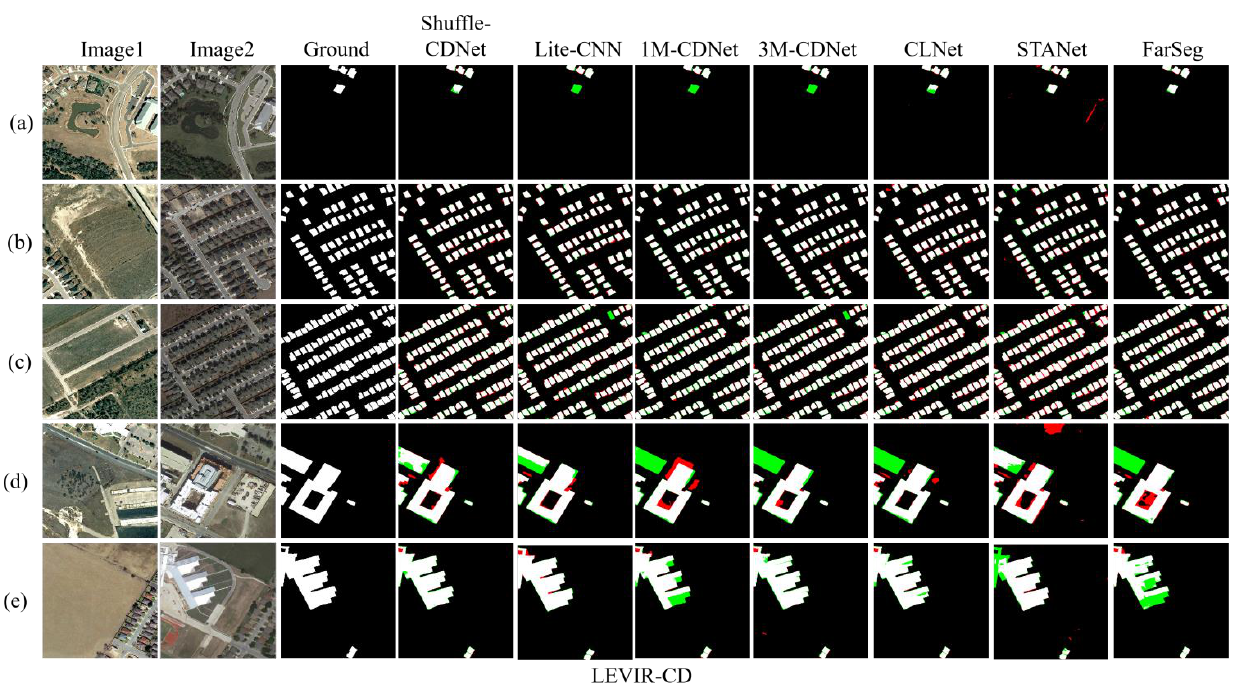
Figure 5. Results on the LEVIR-CD test sets. Different colors are used for a better view, i.e., white for true positive, black for true negative, red for false positive, and green for false negative. ( a – e ) are results of five pairs of bitemporal images.